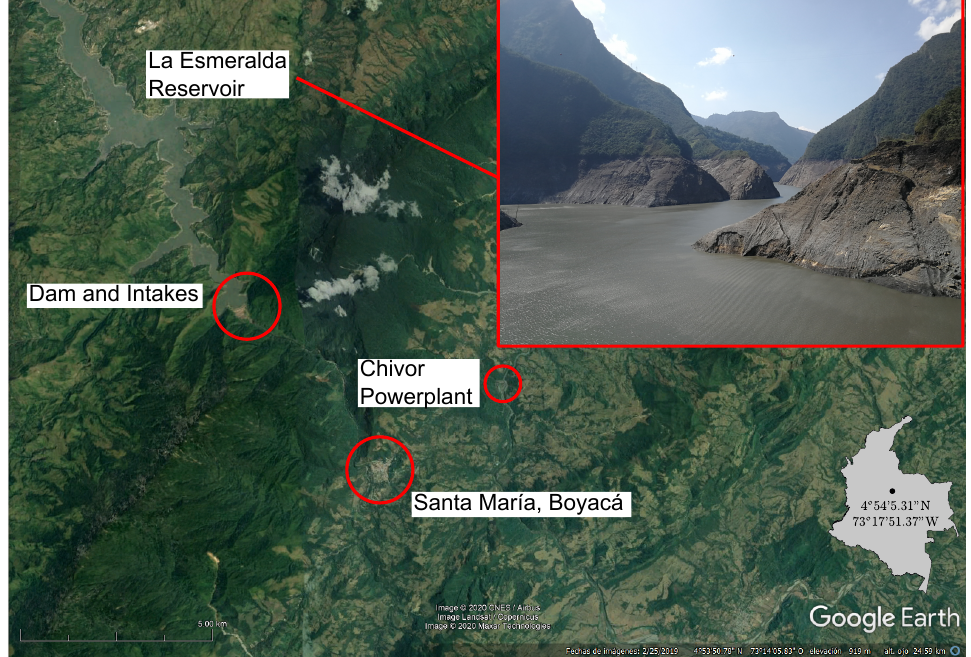
Figure 1. AES Chivor hydropower project: reservoir, dam, intakes, powerplant, and location [50]. Adapted from Google Earth ™ mapping service - Google Earth Pro 7.3.6.9345